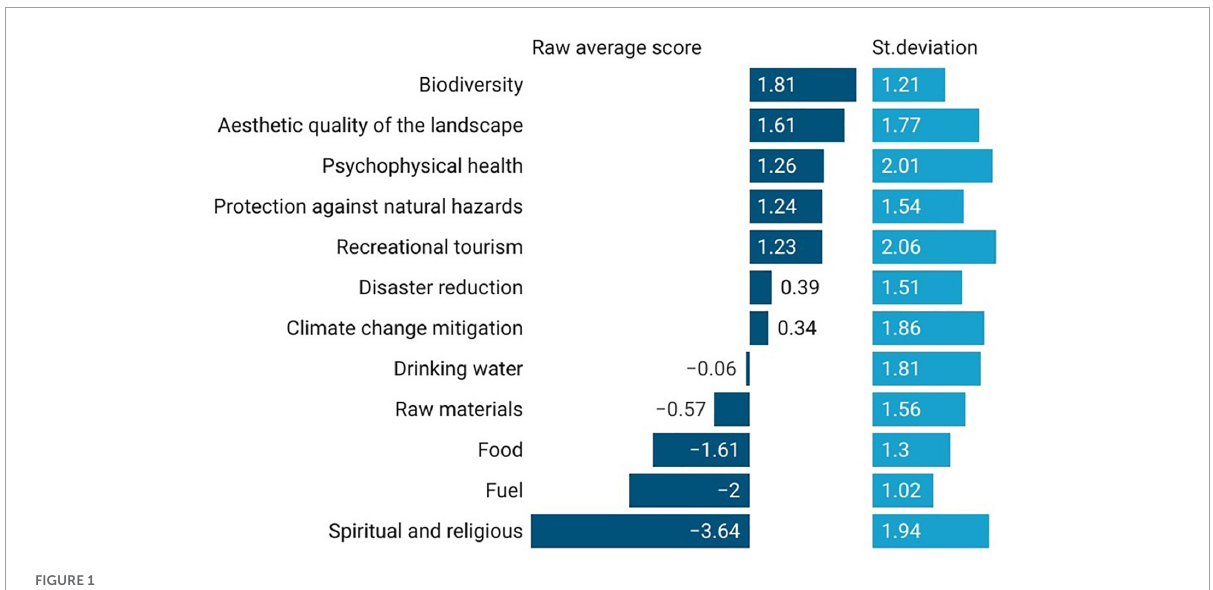
FIGURE1 Raw average score for each FES